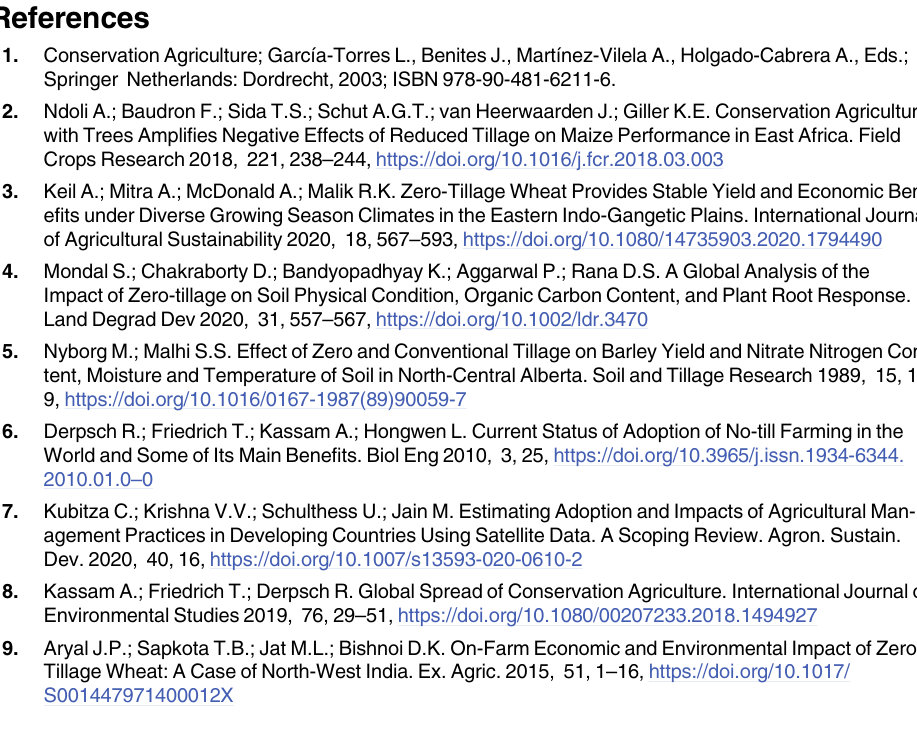
S2 Fig. RGB images of Sentinel-2 and PlanetScope with some ZT/CT fields overlaid on imagery from October, 8, 2017 and VH band image of Sentinel-1 on November, 8, 2017. (TIF) S1 File. Survey conducted with farmers in the